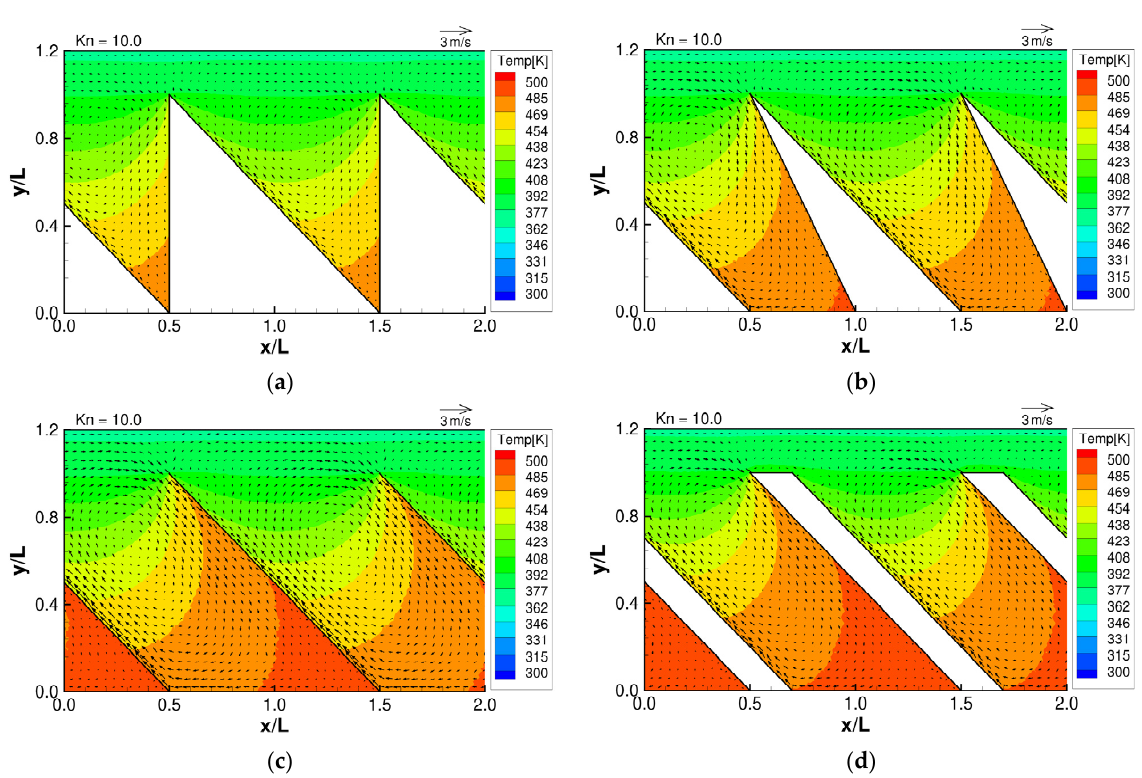
Figure 5. Flow distributions and temperature distributions for ( a ) ratchet, ( b ) modified ratchet, ( c ) oblique plate, and ( d ) oblique ridge, at Kn = 10 .